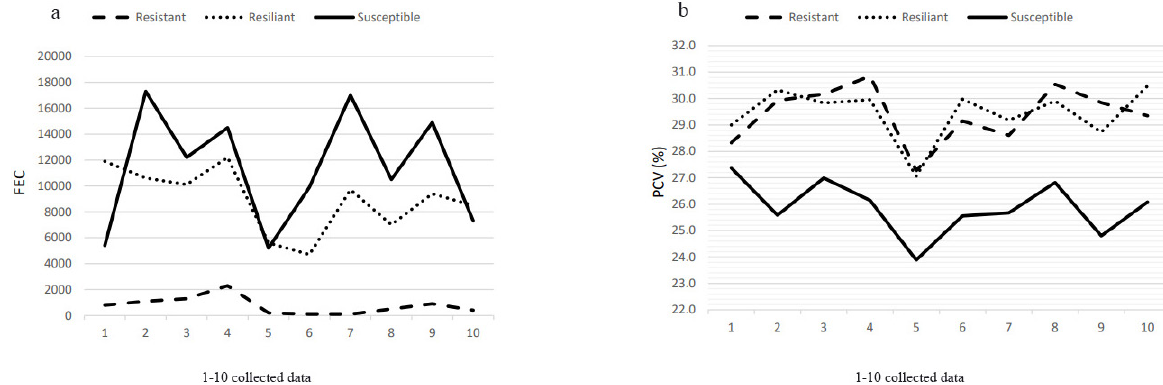
Figure 2. Mean values of the fecal egg count (FEC) (a) and packed cell volume (PCV) (b) of the 60 Morada Nova ewes, throughout the study (1 - 10 data collections over 6